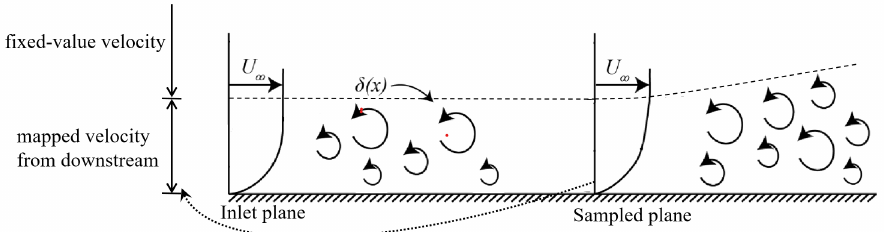
Figure 4. Simulation method of the turbulent boundary layer at the inlet boundary.